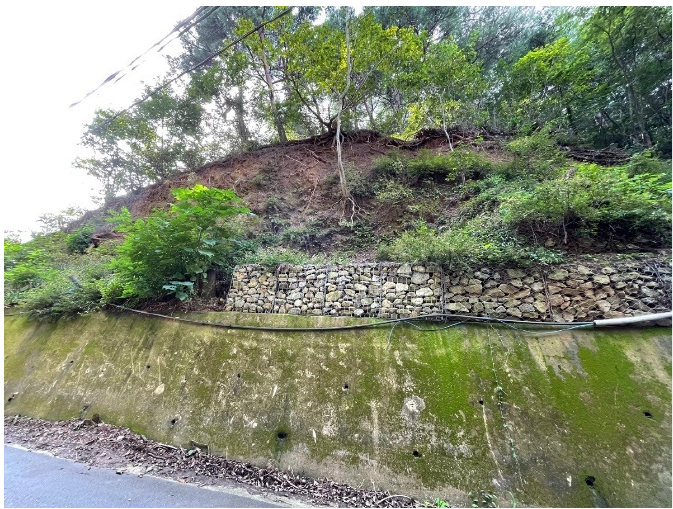
Figure 9. Complex GGSJ (artificial rock slope, concrete embankment).